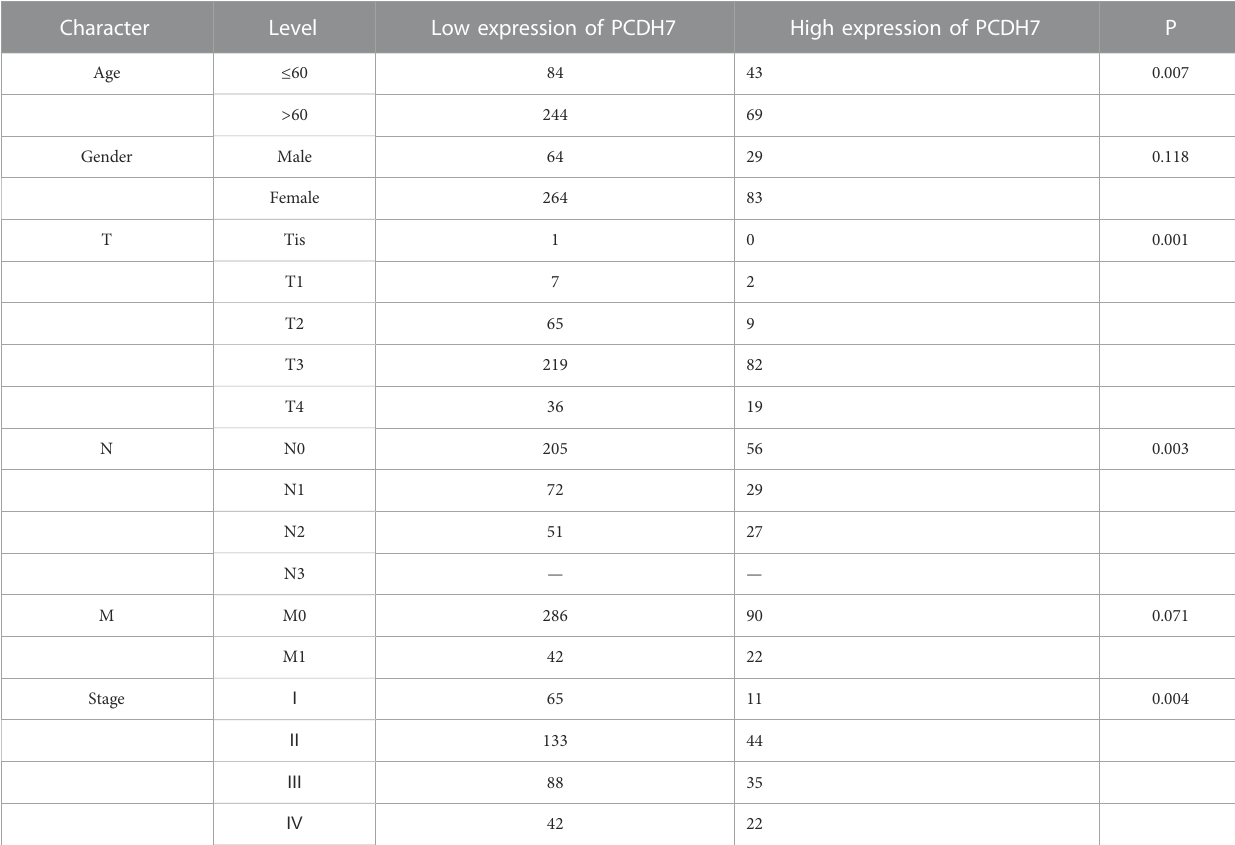
TABLE 1 Association between PCDH7 expression and clinical pathological features in colorectal cancer patients.